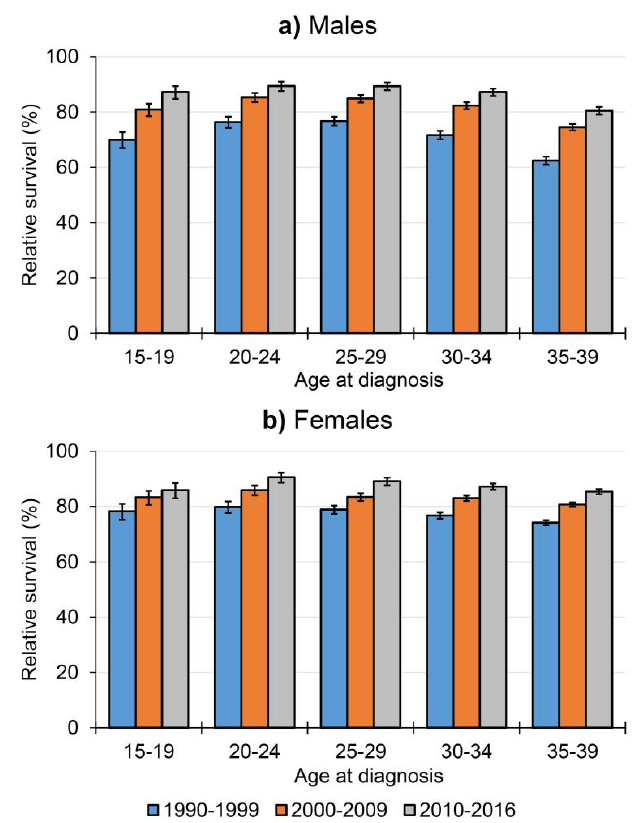
Figure 3. Five-year relative survival outcomes with 95% confidence intervals over time for ( a ) male and ( b ) female adolescent and young adult (AYA) cancer patients by age group in the Netherlands between 1990–2016.